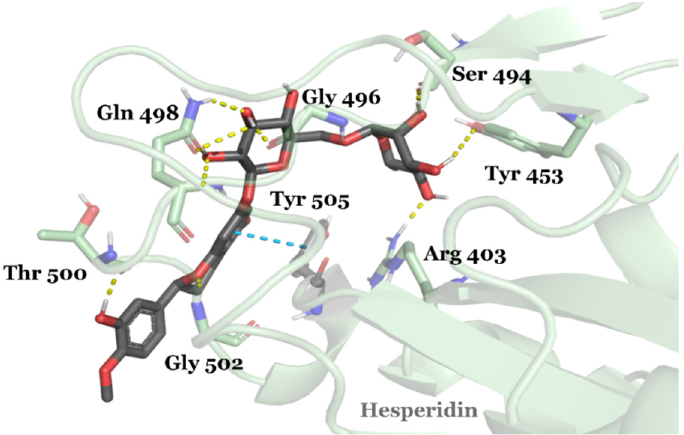
Figure 4. A representative snapshot of the docking pose of hesperidin. The S protein’s residues are colored according to the atom type of the interacting amino acid residues (protein’s carbon, pale green; oxygen, red; nitrogen, blue). Dash lines represent the protein–ligand interactions: hydrogen bond interactions are colored in yellow; π - π interactions are colored in blue.